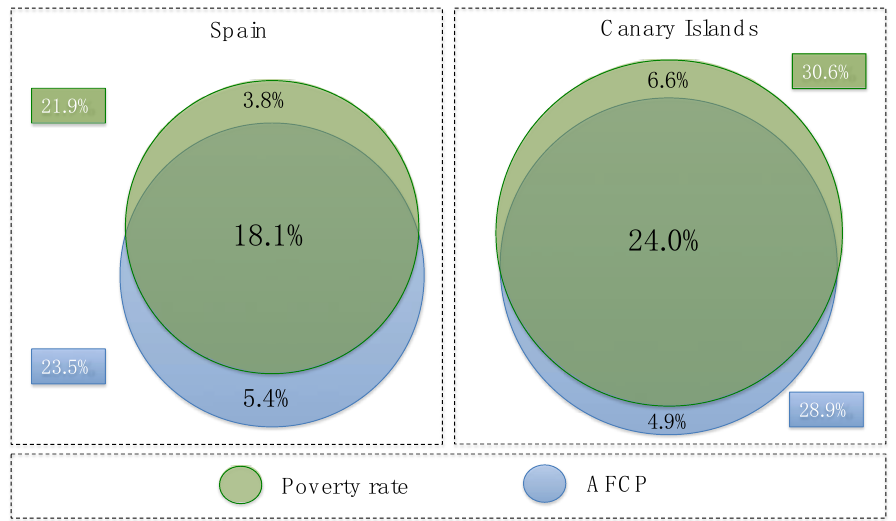
Figure 3. Combined analysis of poverty rate and After Fuel Cost Poverty (AFCP) indicator in Spain and the Canary Islands for the period 2006–2016.